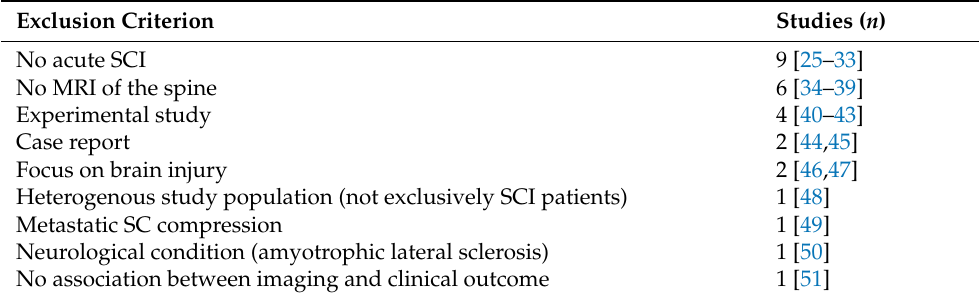
Table 1. Excluded studies of previous literature on prospective studies about acute spinal cord injury, magnetic resonance imaging, and complications ( n = 41)